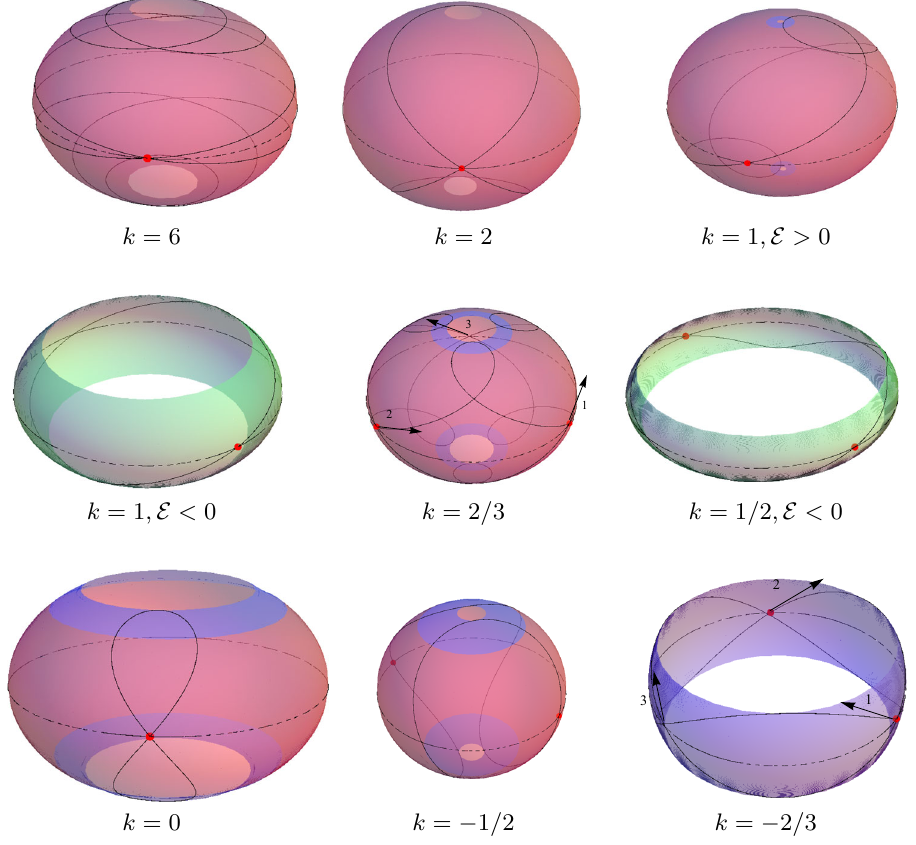
Fig. 9 Various types of the periodic SPOs characterized by k - the number of revolutions about the φ - axis per one latitudinal oscillation. Hereandhereafterweshalldepictingreenthesphereofthephotonorbit with a negative energy, and in red/blue that parts of the spheres, where the photon moves in the positive/negative azimuthal direction, having a positive energy. Figures include cases of the prograde orbits ( k > 0), both with and without the turning point of the azimuthal motion, the oscillating orbit ( k = 0), and the retrograde orbits ( k < 0), with and